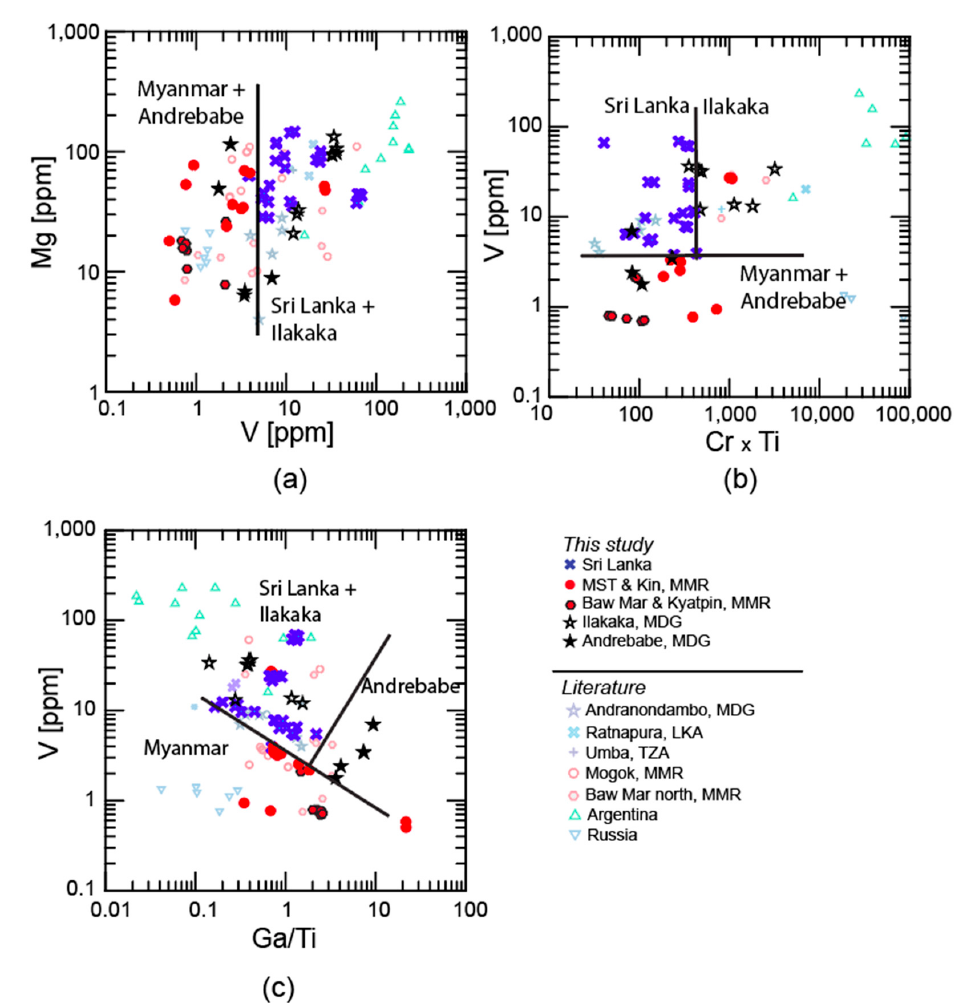
Figure 14. Binary plots of ( a ) Mg (ppm) versus V (ppm), ( b ) V (ppm) versus Cr × Ti (ppm), and ( c ) V versus Ga/Ti for metamorphic blue sapphires analyzed using LA-ICP-MS in this study. Fields are drawn by eye. Additional data from [10,42,43,59].